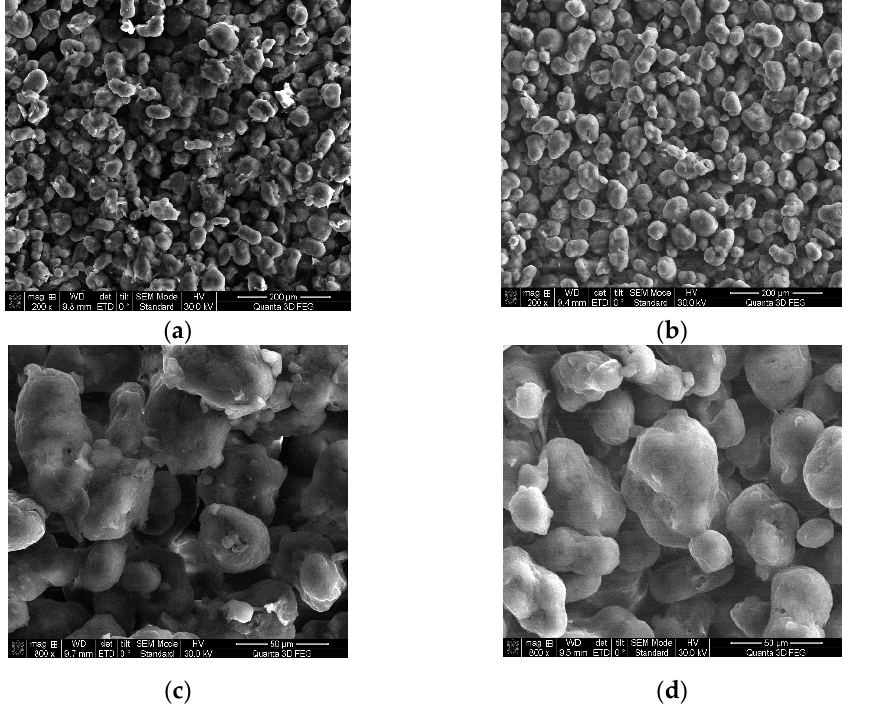
Figure 6. SEM analysis before and after immersion in the paraxylene solution: ( a ) before immersion (200×); ( b ) after immersion (200×); ( c ) before immersion (800×); ( d ) after immersion (800×).